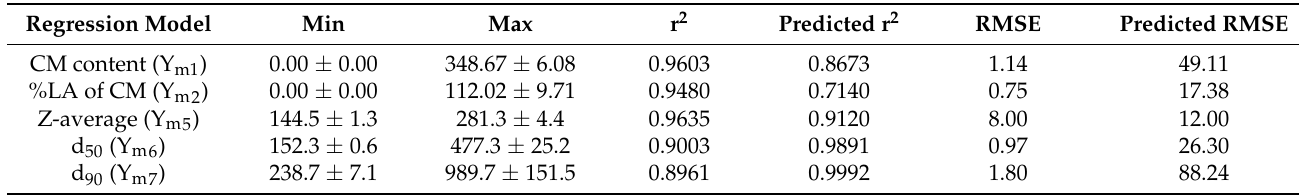
Table 2. The predictive root mean square error (predictive RMSE) and predictive r 2 of all regression model